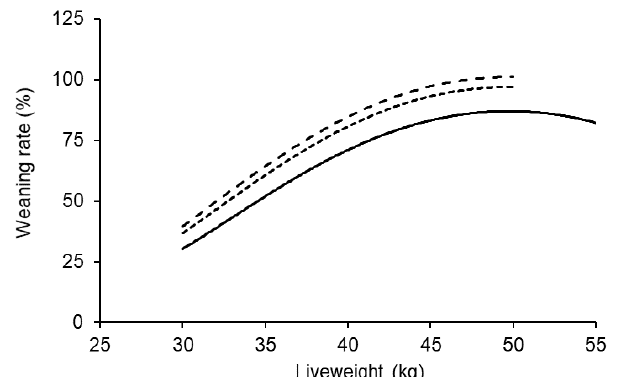
Figure 2. The effect of liveweight at the start of breeding on weaning rate for ewe lambs that were born a single (bottom), twin or triple (top). The data represent over 11,500 maternal composite ewe lambs and weaning rates are predicted at 7.5 months of age. The average 95% confidence interval across all scenarios was ±6.6%.